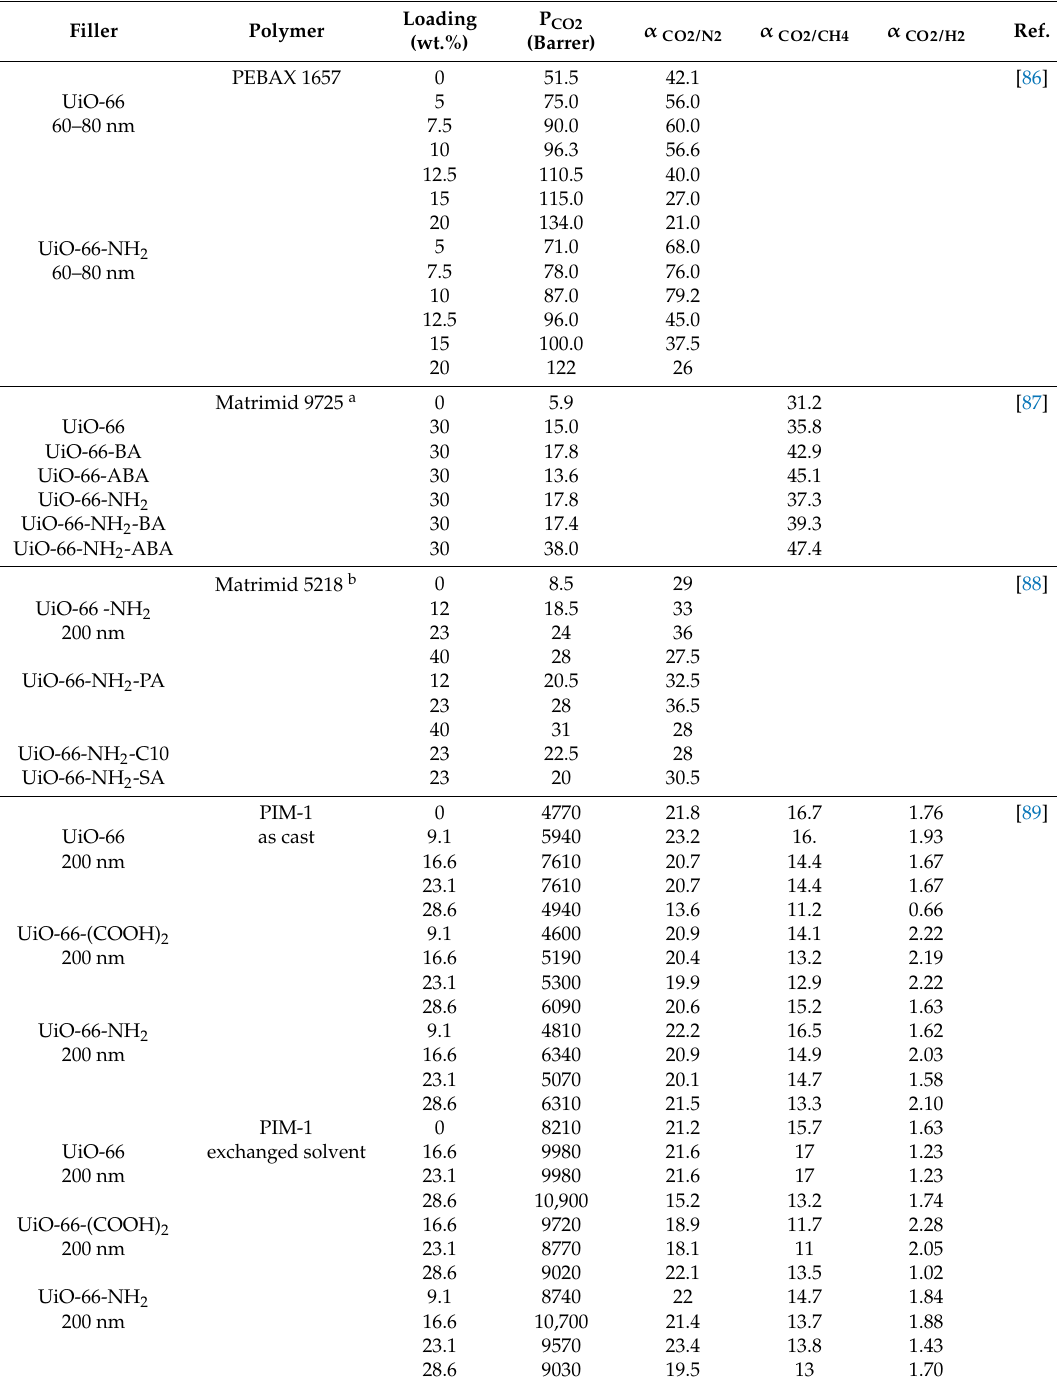
Table 2. Gas separation performance of UiO-66-based mixed matrix membranes (operating conditions ranging within 1–5 bar, 20–35 ◦ C, unless differently